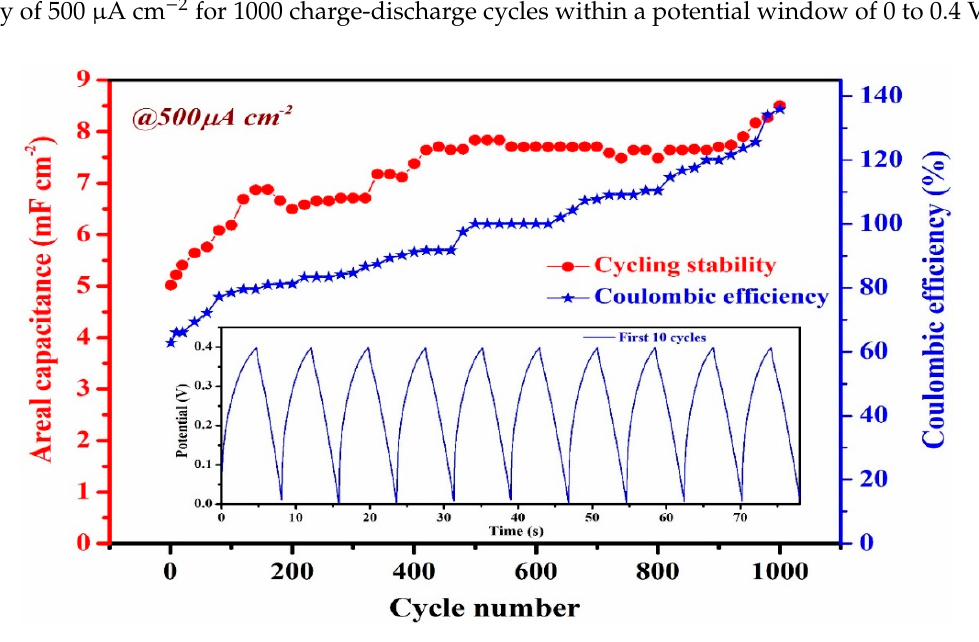
Figure 5. Cycling performance and Coulombic efficiency of sheet-like ZnCo 2 O 4 (inset shows GCD curves for the first ten cycles).